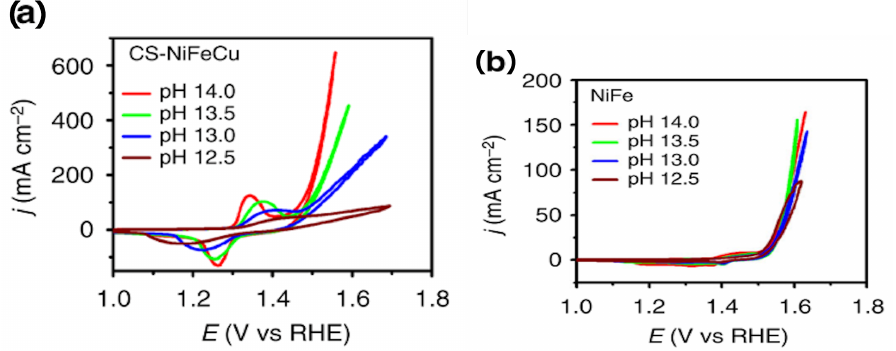
Figure 9. Comparison of p H-dependent OER activity of ( a ) core-shell NiFeCu and ( b ) NiFe. Modified from [122].